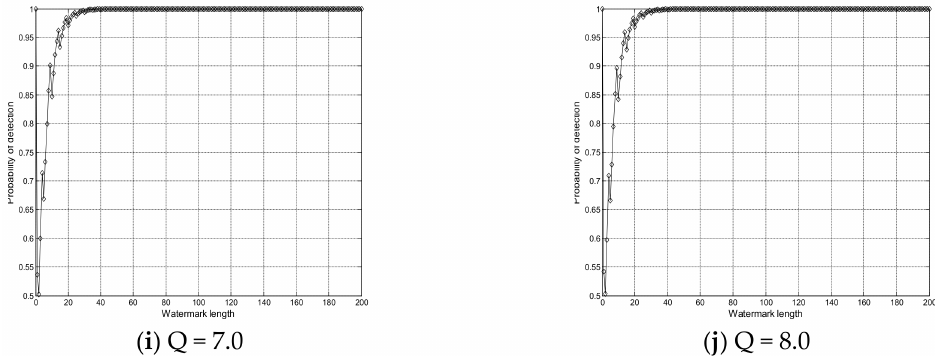
Figure 14. Probability of detection with respect to quantization parameter.